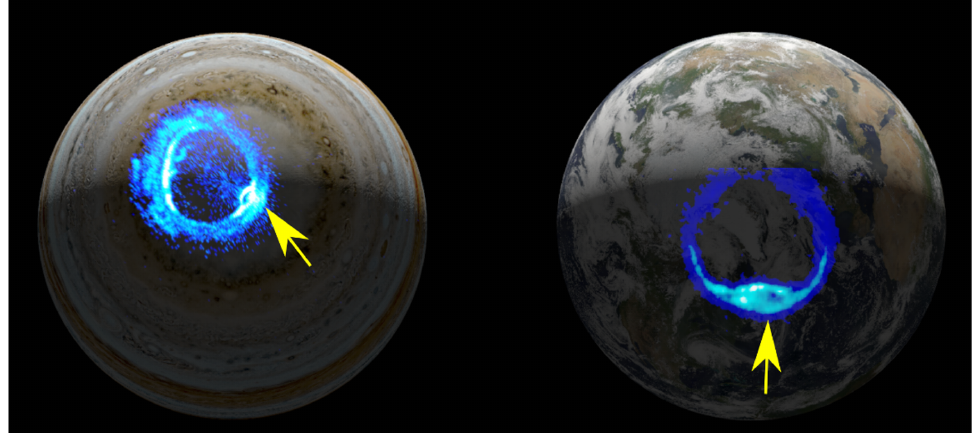
Figure 5. Polar projection of Jupiter’s southern and Earth’s northern hemisphere showing UV auroral emissions, placed over simulated visible light images of each planet (not to scale). The left image shows imagery from the Juno spacecraft’s UVS (Ultraviolet Spectrograph) instrument. The image on the right corresponds to Earth’s aurora as seen from the Wide-field Imaging Camera (WIC) on board NASA’s Imager for Magnetopause-to-Aurora Global Exploration (IMAGE) spacecraft. The yellow arrows indicate auroral ‘dawn storms’ on both planets. Figure from the associated press release of [65].